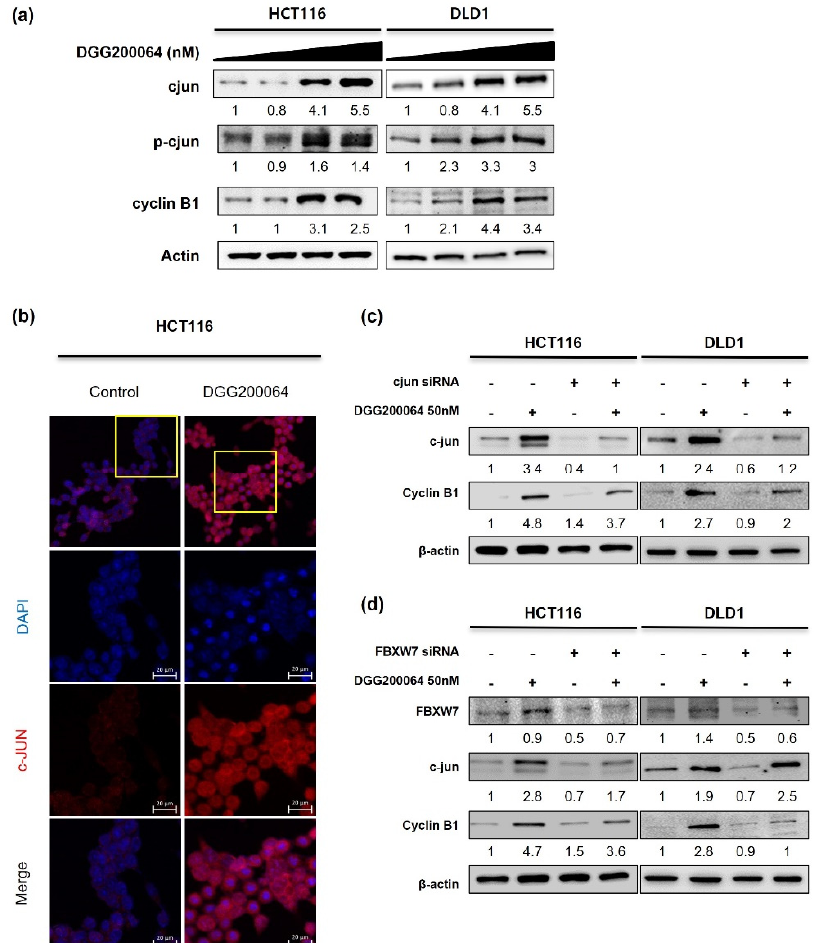
Figure 3. c-Jun stabilization by DGG200064 : ( a ) HCT116 and DLD1 treatment with DGG200064 in a dose-dependent manner (0, 10, 50, 100 nM). The effect of G2/M cell cycle arrest induced by DGG200064 treatment for 6 h in HCT116 and DLD1 cells. Expression was investigated with the following antibodies: c-Jun, p-c-Jun, cyclin B1, and β -actin; ( b ) c-Jun stabilization expression in HCT116 cells exposed to DGG200064 (50 nM) for 6 h. Immunocytochemistry analysis in HCT116 cells using anti c-Jun primary antibody, fluorophore-conjugated anti-mouse immunoglobulin secondary antibody and counterstained with DAPI to visualize nuclei. The scale bar was 20 μ M. ( c ) After HCT116 and DLD1 cells were transfected with siRNA targeting c-Jun for 24 h, the cells were treated with DGG200064 (50 nM) for 6 h. Whole-cell lysates were subjected to immunoblotting with the indicating antibodies to c-Jun, cyclin B1, β -actin. ( d ) The siRNA targeting FBXW7 transfected in HCT116 and DLD1 cells for 24 h. Then these cells were treated with DGG200064 (50 nM) for 6 h in HCT116 and DLD1 cell. Whole-cell lysates were analyzed by immunoblotting with antibodies to FBXW7, c-Jun, cyclin B1, and β -actin.